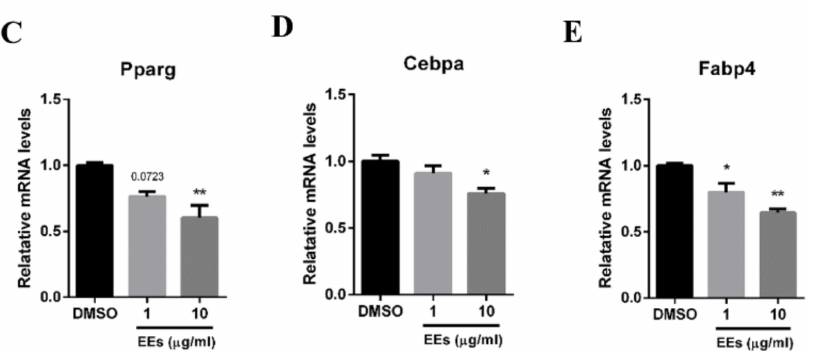
Figure 1. Effects of EEs on differentiation of mIPA. ( A ) mIPA differentiation was induced with differentiation media containing EEs every 2 days until day 6. ( B ) Differentiated cells were treated with EEs and stained with ORO. ORO dye was extracted with 100% isopropanol and absorption was measured at 490 nm. ( C – E ) Expression levels of Pparg , Cebpa , and Fabp4 were assayed by real-time qPCR. Results are shown as mean ± SEM ( n = 3). *, p < 0.05; **, p < 0.01 compared to the untreated control